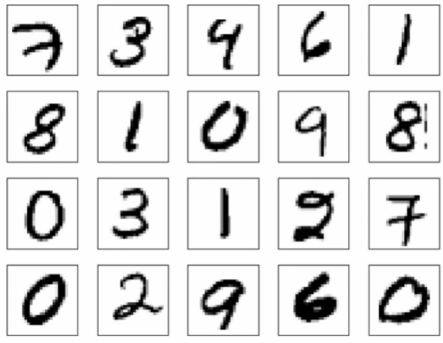
Figure 1. MNIST data set sample image.